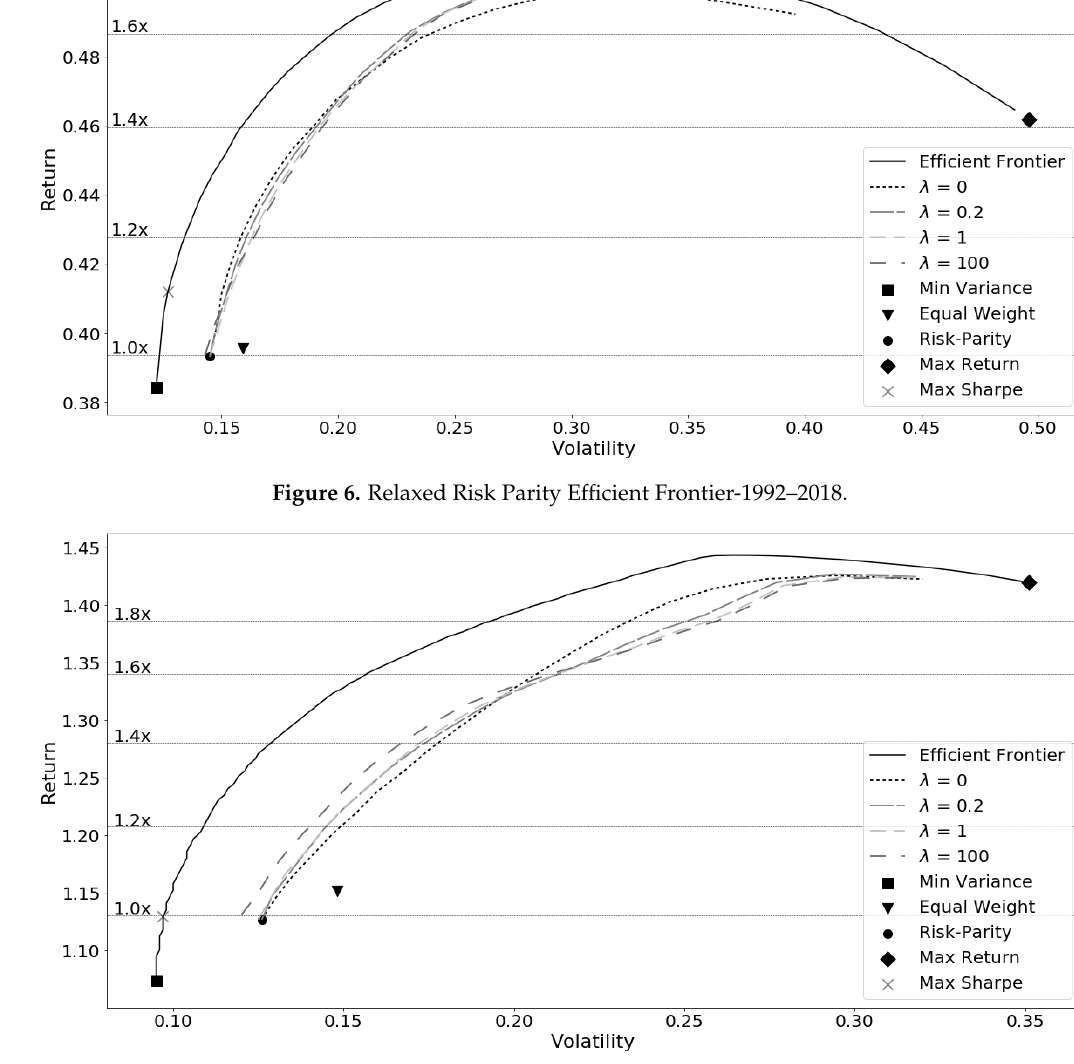
Figure 7. Relaxed Risk Parity Efficient